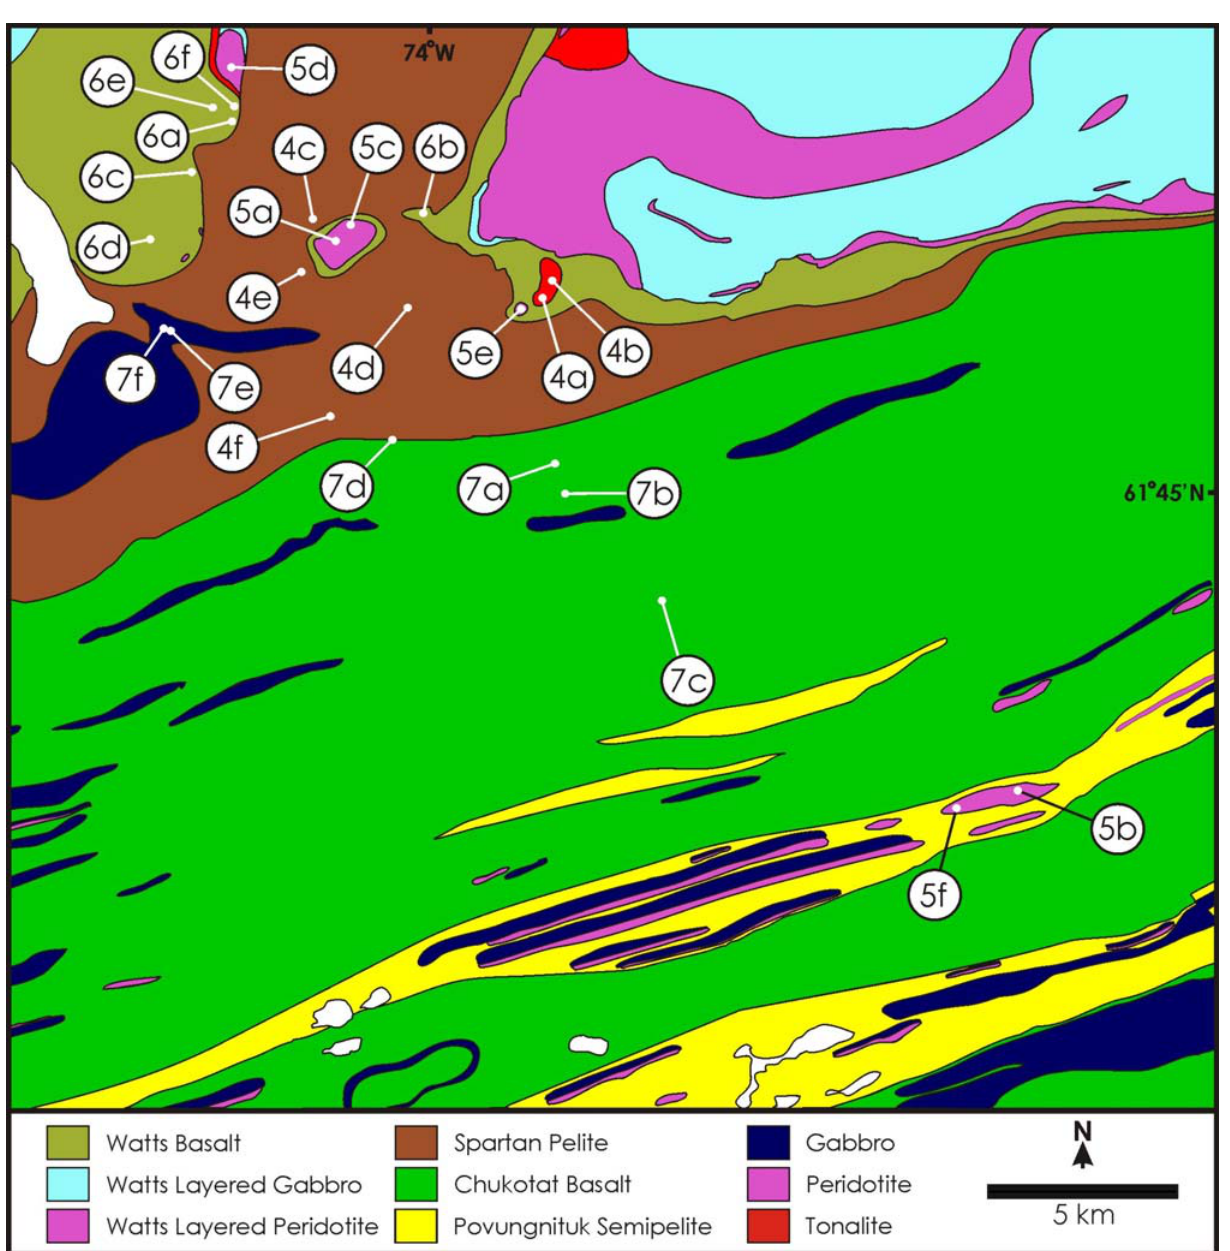
Figure 2. Bedrock geology of the study area (after [36]). Water bodies are depicted in white. The large water body in the northwestern part of the study area is Lac Watts. The locations of field sites depicted in Figures 4 to 7 are